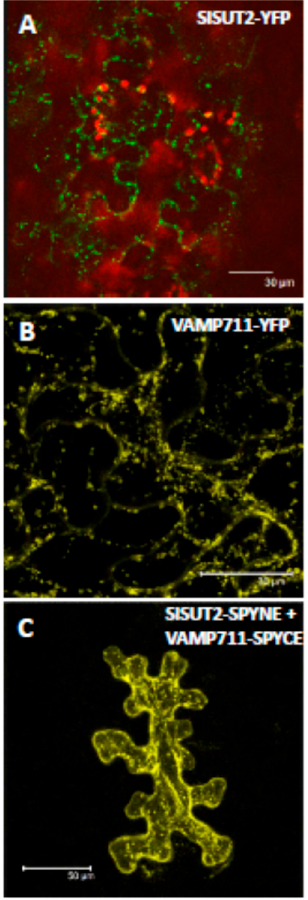
Figure 4. Confirmation of interaction between SlSUT2 and its interaction partner v-SNARE / VAMP711. ( A ). SlSUT2-YFP transiently expressed in leaves of N. benthamiana 4 d after infiltration. Chlorophyll is shown in red, YFP fluorescence is shown in green. ( B ). The full-length v-SNARE / VAMP711 in pK7GW2.0 (YFP) transiently expressed in leaves of N. benthamiana . YFP fluorescence is shown in yellow. ( C ). BiFC experiments confirming SlSUT2 and v-SNARE / VAMP711 interaction using the BiFC vectors SPYNE and SPYCE. Maximum projections of z-stacks are shown.